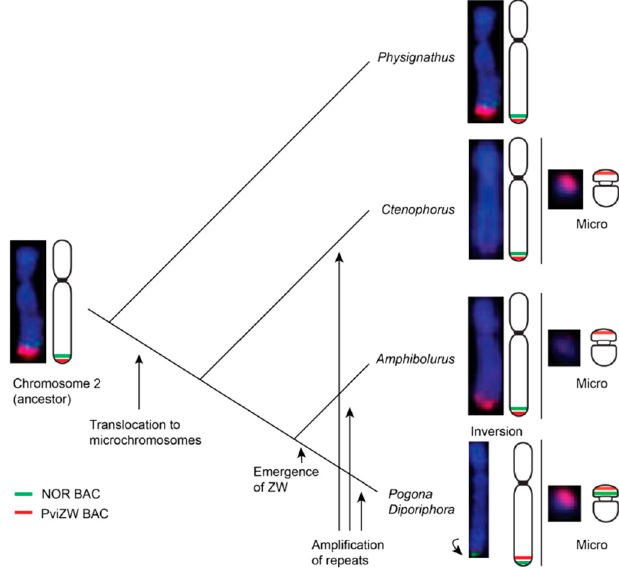
Figure 3. Schematic diagram showing plausible mechanisms of chromosomal rearrangements and evolution of sex chromosomes in GSD dragon lizards. Chromosomal locations of Pogona vitticeps sex chromosome BAC clone Pv151P16 and NOR BAC clone AGI329J14 are indicated in red and green colours, respectively. Arrows indicate possible evolutionary events including translocation, amplification of repeats and inversion leading to the evolution of the ZZ/ZW sex microchromosome system in Pogona and Diporiphora lineages. Truncated phylogeny (not according to scale) is derived from [29].